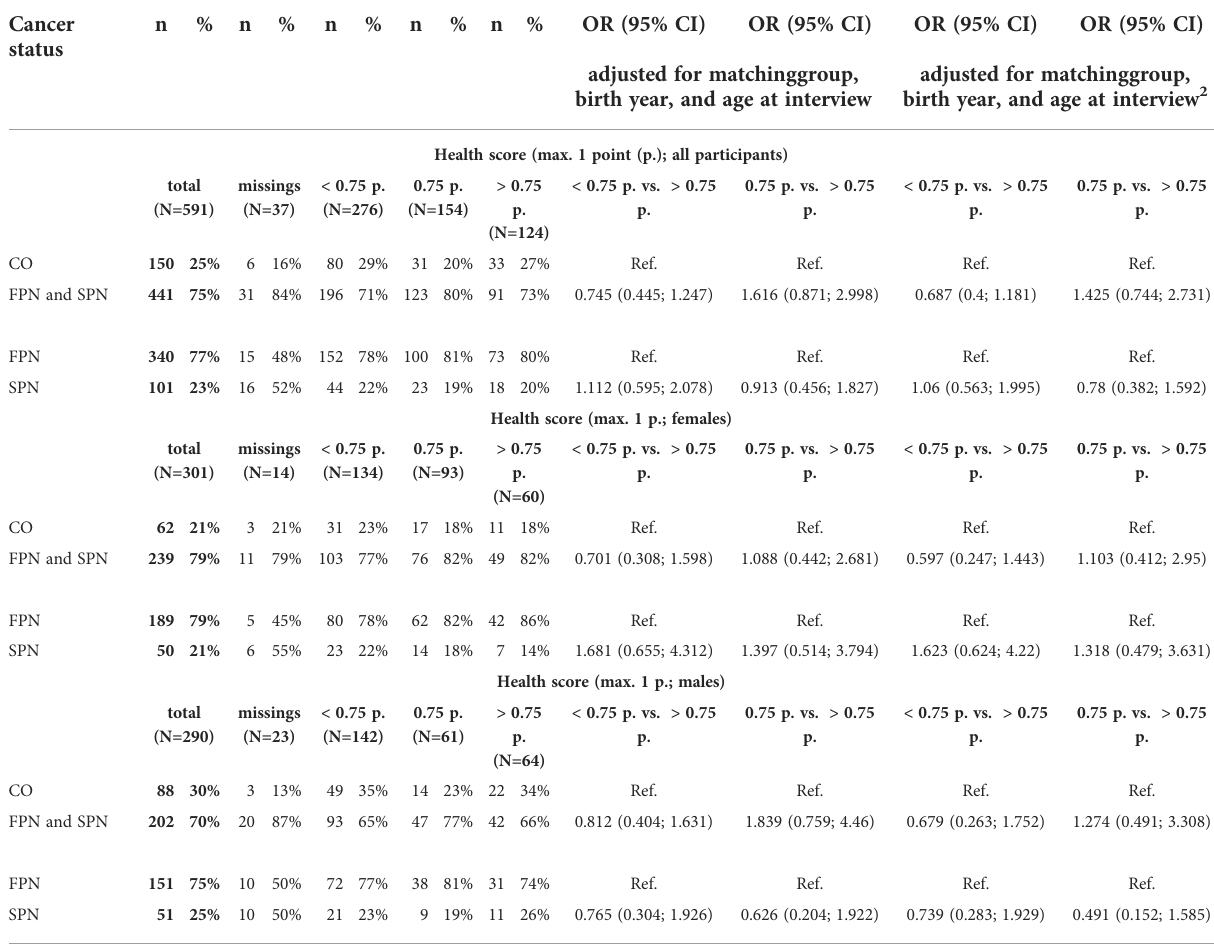
TABLE 5 Multinomial logistic regression on cancer status and calculated health score 1 . Cancer status